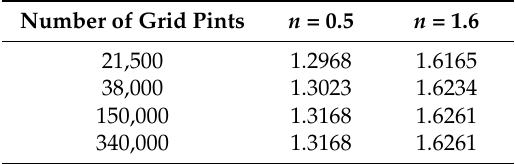
Table 1. Values of drag coefficient for Re = 100, n = 0.5 and n = 1.6 (mesh resolution